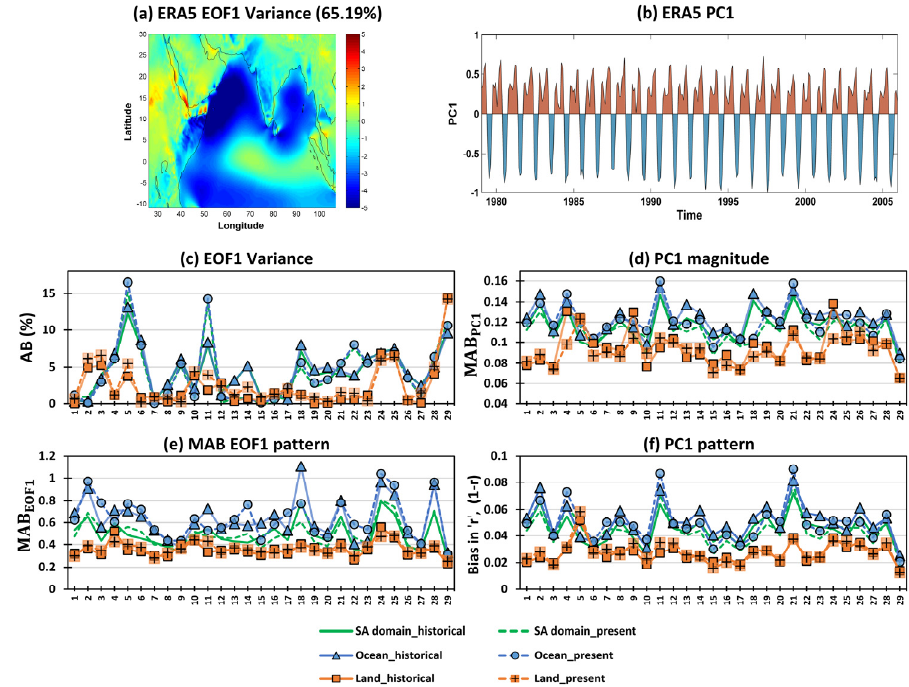
Figure 3. ( a ) The first mode of ERA5 historical monthly mean wind speed EOF, ( b ) first principal component (PC1) of ERA5 historical monthly mean wind speed EOF1. ( c − f ) As in Figure 2, but represents Assessment Criterion Statistic (ASC) summary of all climate models in representing the spatio-temporal variability of monthly mean wind speed; ACS (AB = absolute bias; MAB = mean absolute bias, r = correlation coefficient) on y-axis and Model ID on x-axis.